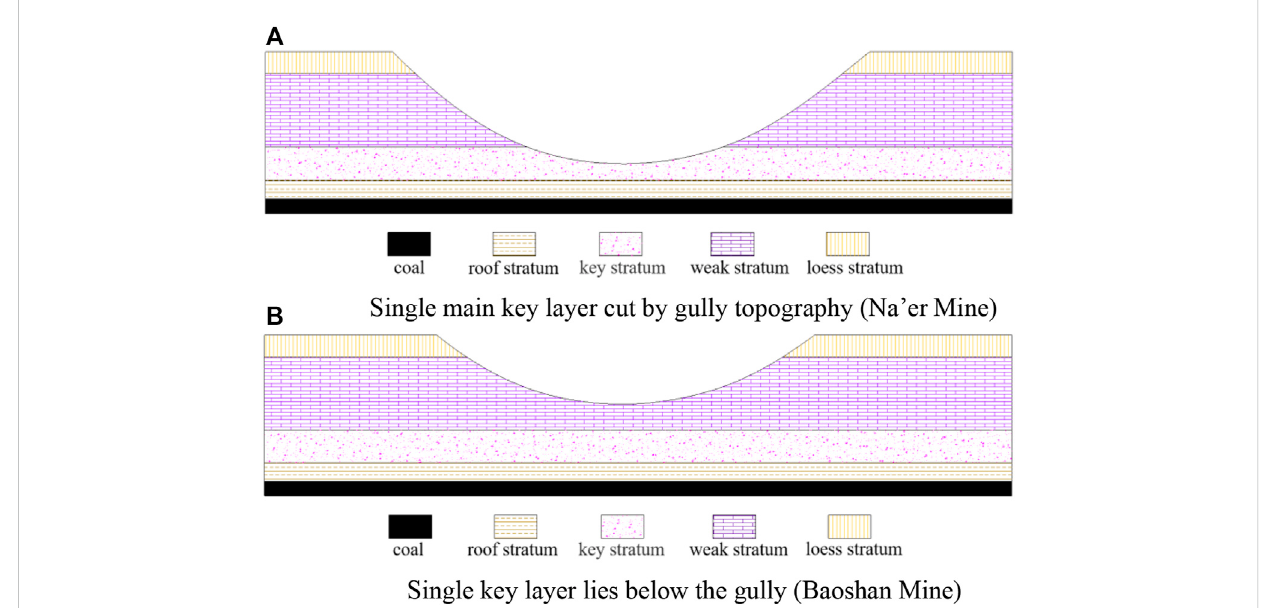
FIGURE 1 Occurrence structure of the gully slope. (A) Single main key layer cut by gully topography (Na ’ er Mine). (B) Single key layer lies below the gully (Baoshan Mine).